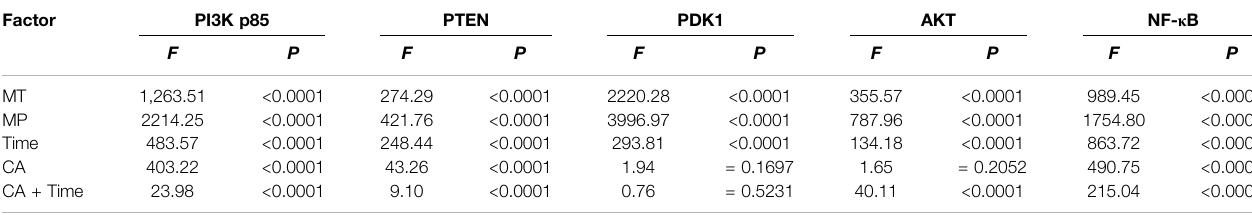
TABLE 3 | ANOVA of the PI3K-AKT1 signaling pathway in rats: main effect and interaction results.